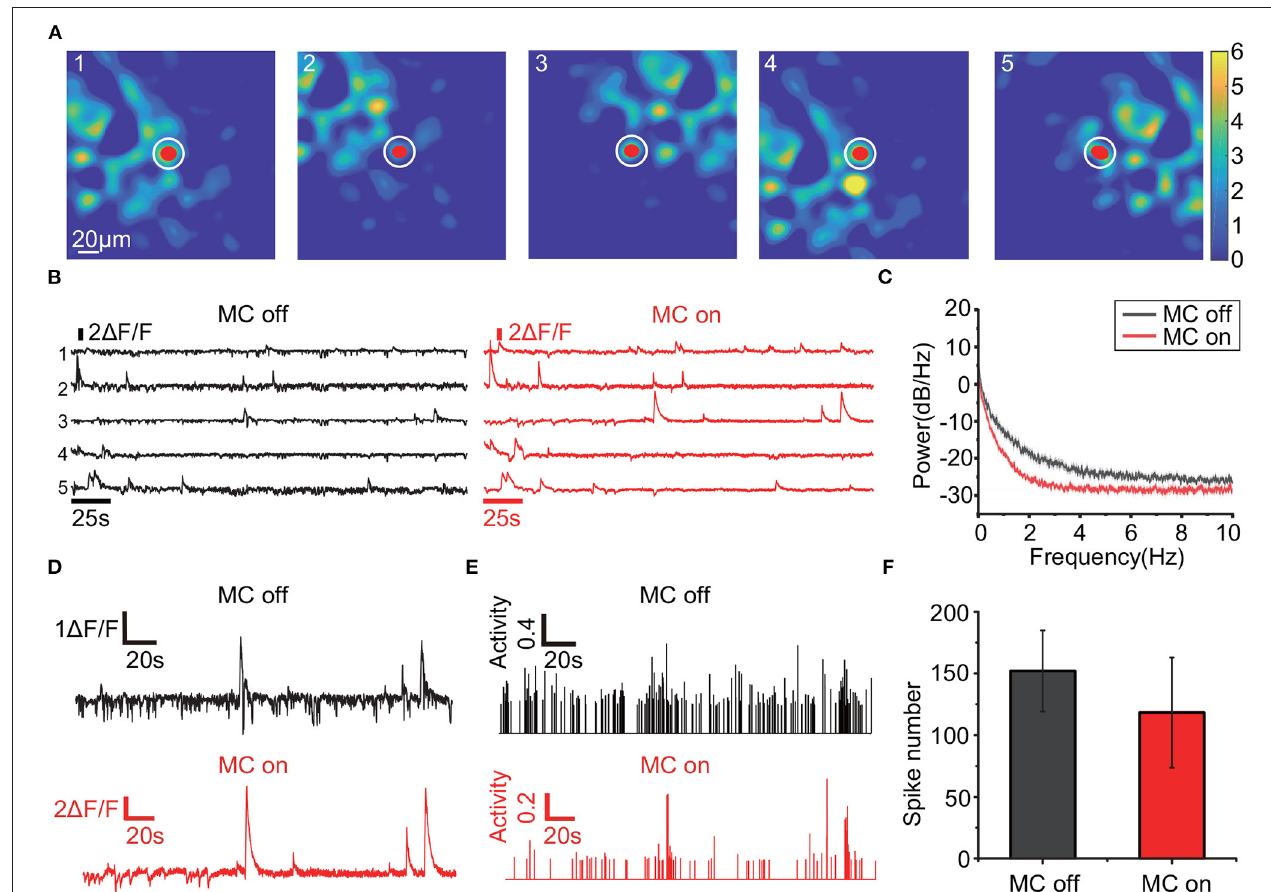
FIGURE 6 | Traces comparison when RTMC is on and off. (A) : Positions of the 5 observed neurons (red dots) and the local background (white circles). The trace of each neuron is obtained by subtracting the mean fluorescence values of the regions covered by the neuron from the local background. (B) : The traces of the 5 neurons in (A) . The black traces were extracted without motion correction, while the red traces were extracted with motion correction using RTMC. (C) : Mean power spectrum of the traces with (red) and without (black) motion correction from 3 mice (15 neurons). The shaded area indicates the s.e.m. (D) : Enlarged example trace of the third neuron in (A) before and after motion correction. (E) : Spikes of the third neuron in (A) extracted by OASIS before and after motion correction. The spikes were thresholded by 3 SD of the inferred spikes activities. (F) : Mean number of spikes from the neurons in (C) extracted by OASIS. The error bar indicates the